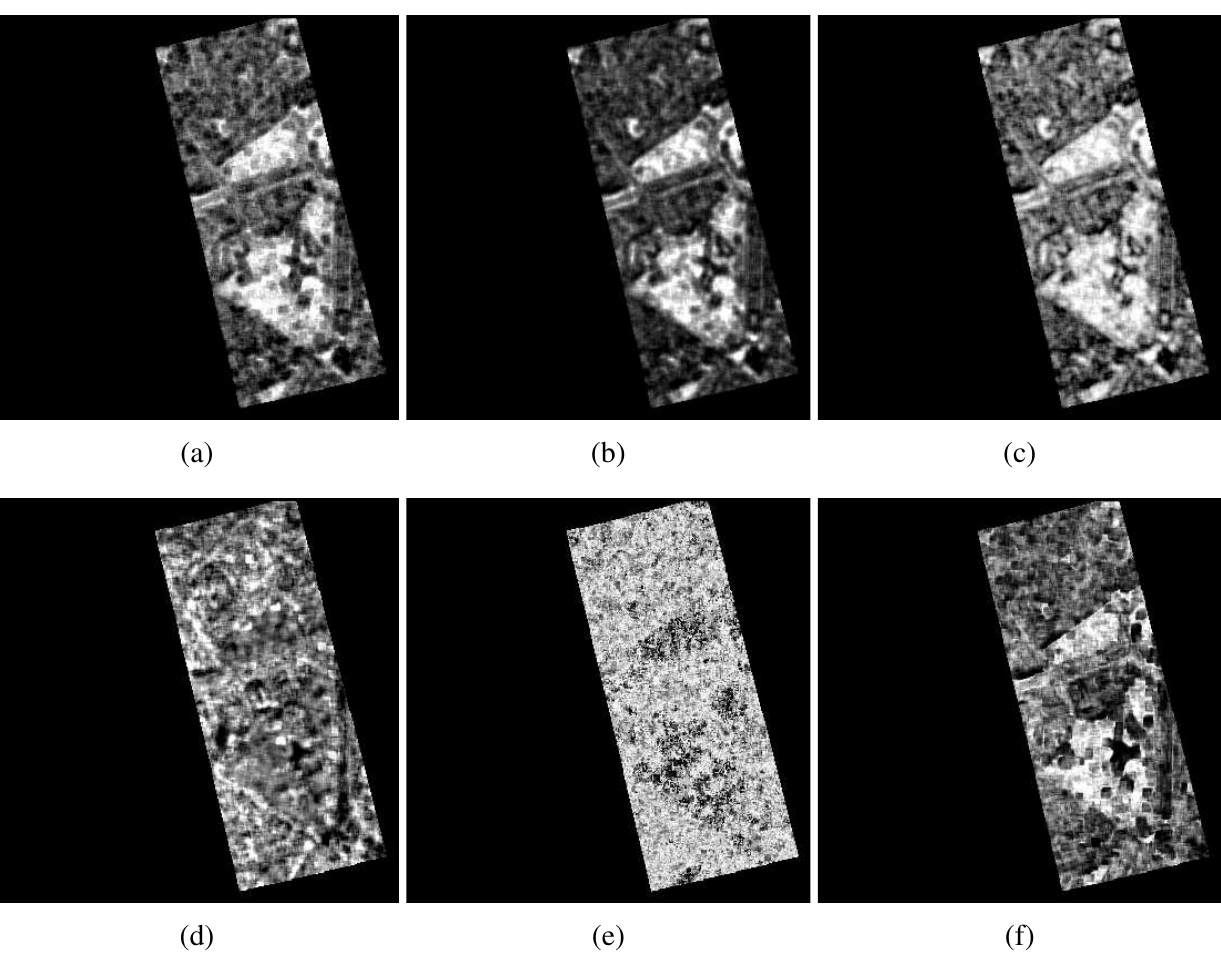
Figure 4. Similarity images of the push-broom and XS data - case a : (a) distance to in- dependence; (b) mutual information; (c) cluster reward algorithm; (d) Woods criterion; (e) robust Woods criterion; (f) correlation